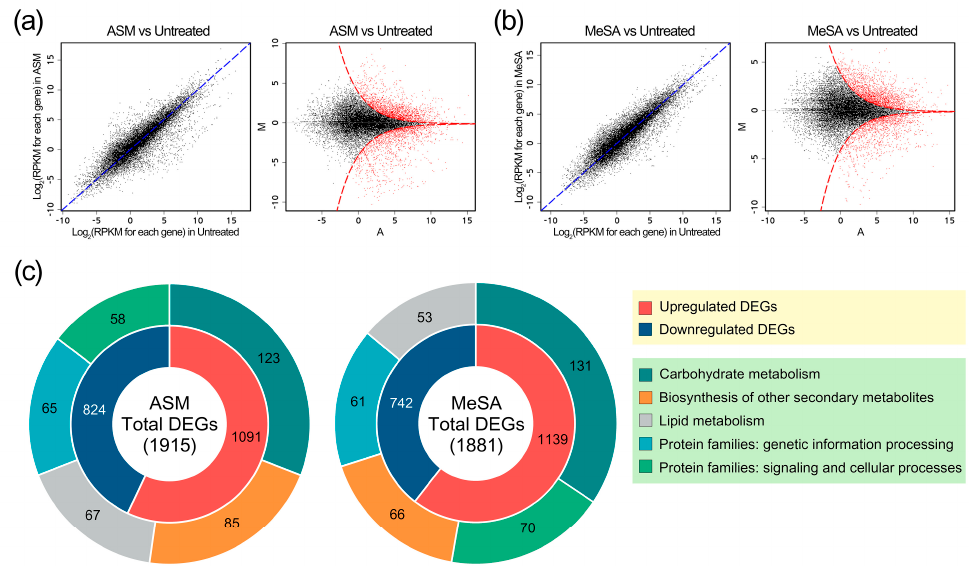
Figure 2. Overview of the di ff erentially expressed genes (DEGs) in acibenzolar- S -methyl (ASM) and methyl salicylic acid (MeSA) treatments. Di ff erential expression was analysed using scatter plots and M (log ratio) against A (mean average) scales (MA-plots) in the DEGseq package. Each point represents one of 45,528 non-redundant genes in pine trees. ( a ) Comparison of the ASM-treated and untreated samples. The scatter plot depicts di ff erences in gene expression between the two groups after normalisation. Genes showing significant di ff erences in expression are indicated by red colour in the MA-plot (false discovery rate, FDR < 0.05). ( b ) Comparison of the MeSA-treated and untreated samples. ( c ) Donut charts illustrating the distribution of DEGs and functional hierarchies. The inner layer shows the distribution of upregulated and downregulated DEGs, and the outer layer comprises the top five functional categories. The size of ring segments is indicative of the relative proportion of DEGs in each